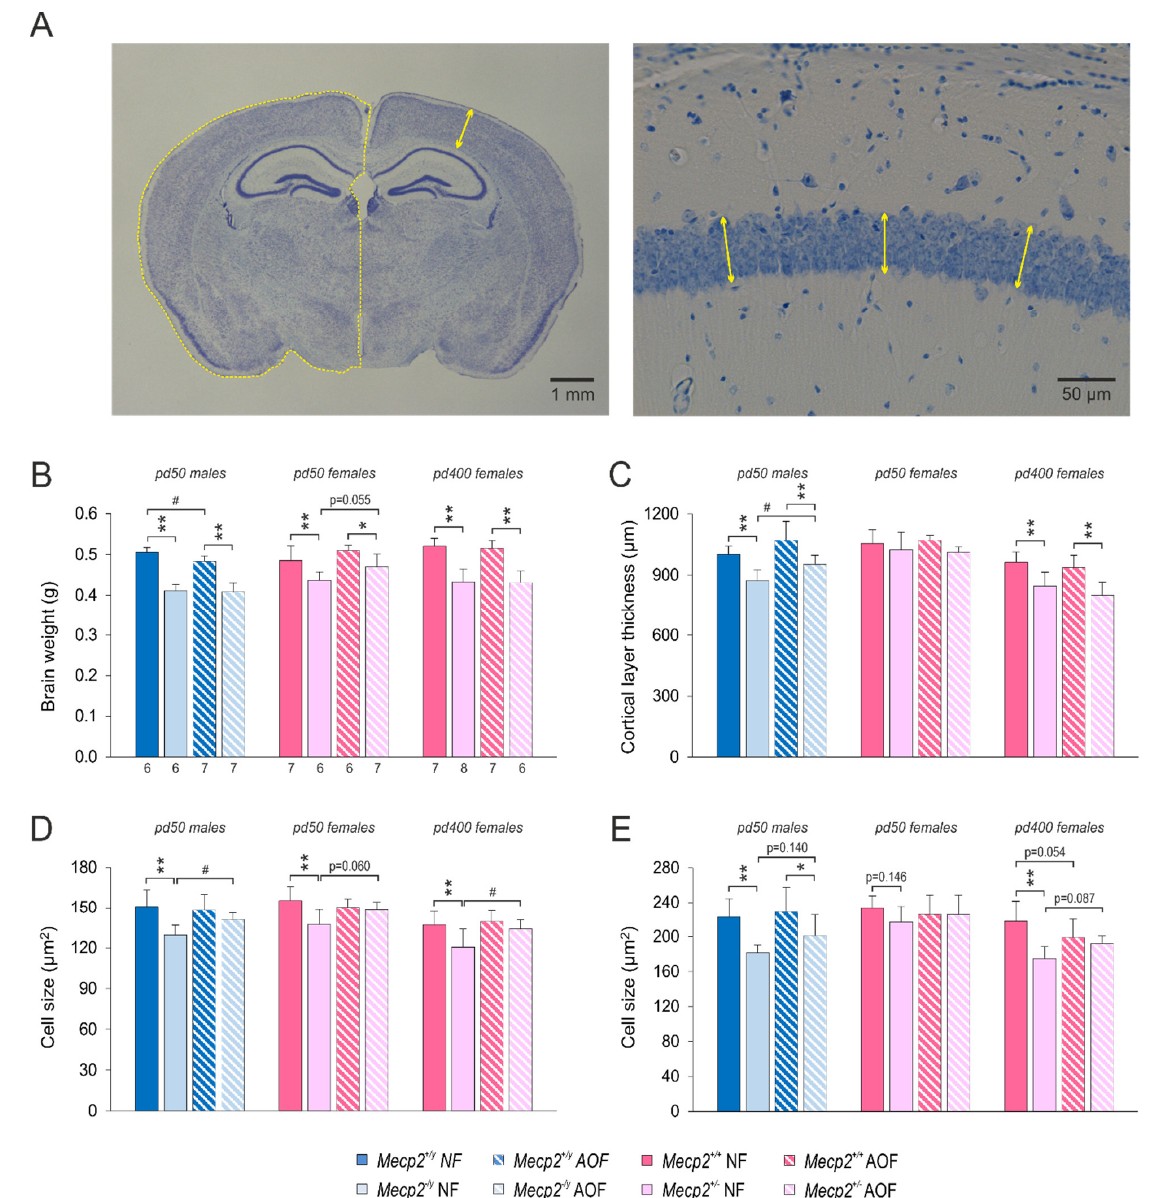
Figure 6. Different aspects of brain morphology showed a partial rescue by AO treatment. ( A ) Nissl- stained tissue sections were obtained from a rostro-caudal position of −1.7 mm with respect to Bregma to quantify hemisphere size, cortical-layer thickness, and the size of individual neurons. Displayed is a section of an AO-treated WT male and a close-up view of CA1 str. pyramidale with an indication of the performed measurements. ( B ) Total brain weight was decreased in all Mecp2 -mu- tant mice, but AO food only tended to rescue the brain weight of female Mecp2 +/− mice on pd 50. Plotted weights refer to perfusion-fixed brains (4% PFA), and the number of mice studied is re- ported. Asterisks indicate statistically significant differences as compared with the respective WT groups (* p < 0.5, ** p < 0.01). AO-treatment-mediated differences among either WT or Mecp2 -mutant mice are indicated by crosshatches (# p < 0.05). All patterns also apply to the other panels. ( C ) The cortex was thinner in male and pd 400 female Mecp2 -mutant mice, but total layer thickness was only improved by AO treatment in male Mecp2 −/ y mice. ( D ) The CA1 pyramidal neurons were smaller in male and female Mecp2 -mutant mice, and their size was rescued or tended to be rescued by the AO cocktail. ( E ) The CA3 pyramidal neurons were smaller in Mecp2 −/ y mice and in Mecp2 +/− mice on pd 400, but these differences were not restored by AO treatment.